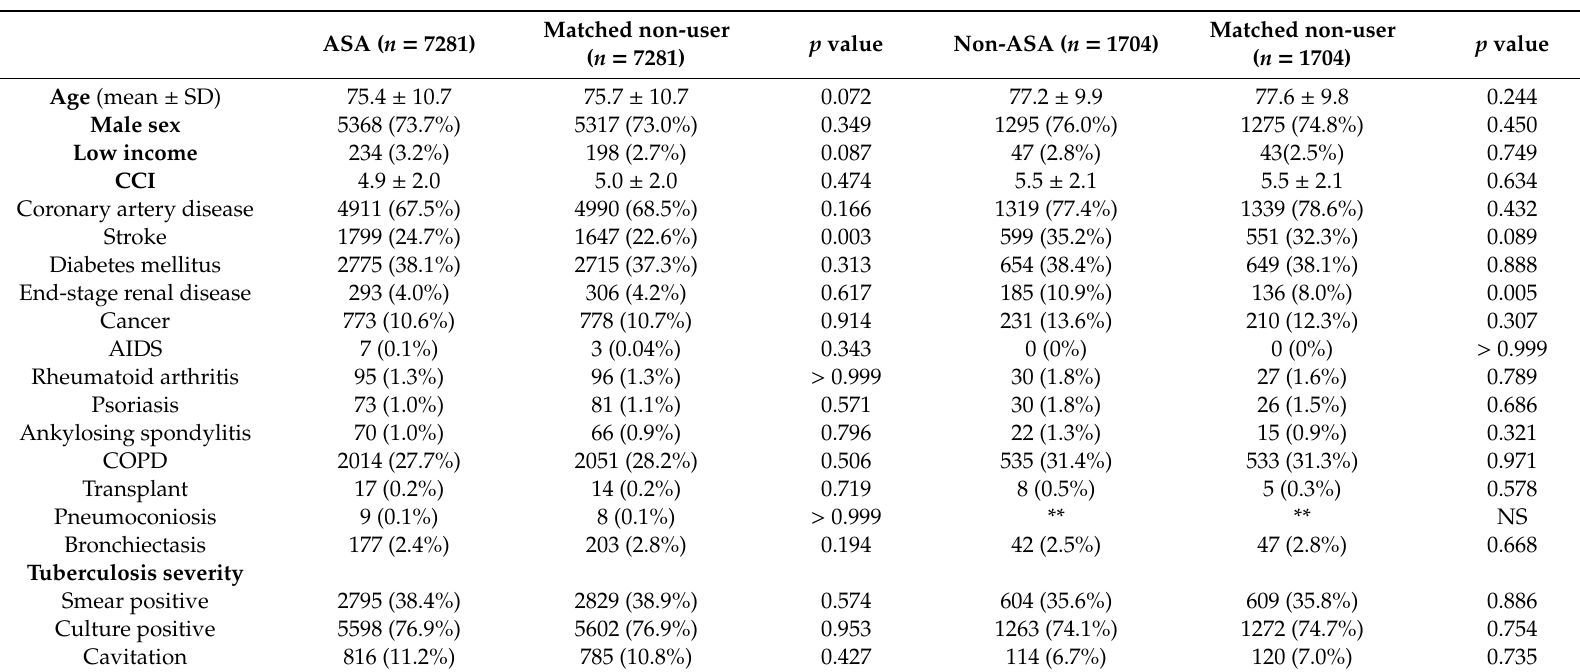
Table 2. Subgroup analysis of aspirin users (ASA), non-aspirin antiplatelet users (non-ASA), and non-antiplatelet users (non-user) after propensity-score